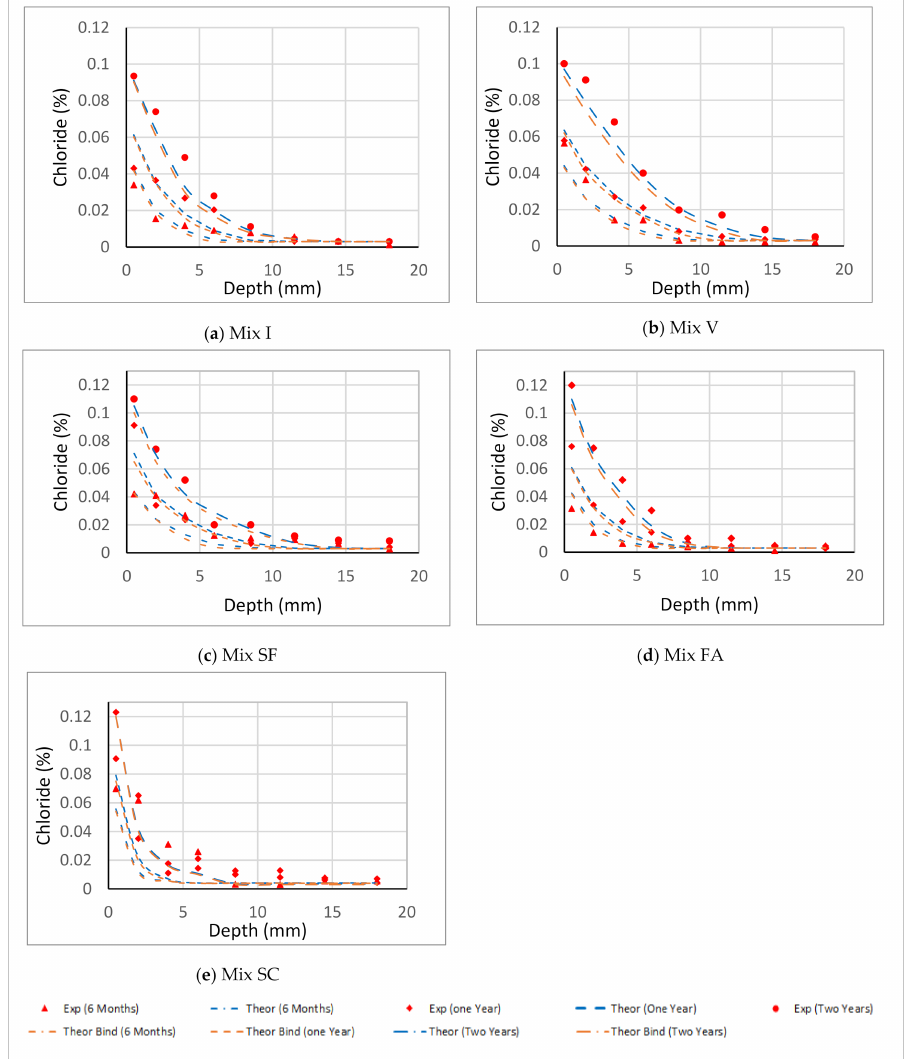
Figure 8. Chloride profiles for mixes in the coastal zone using the new binding model. ( a ) concrete with 100% ordinary Portland cement (OPC), ( b ) concrete with 100% type V cement (Sulfate resistance), ( c ) concrete with 6% silica fumes and 94% OPC, ( d ) concrete with 25% fly ash and 75% OPC, ( e ) concrete with 70% slag cement and 30%